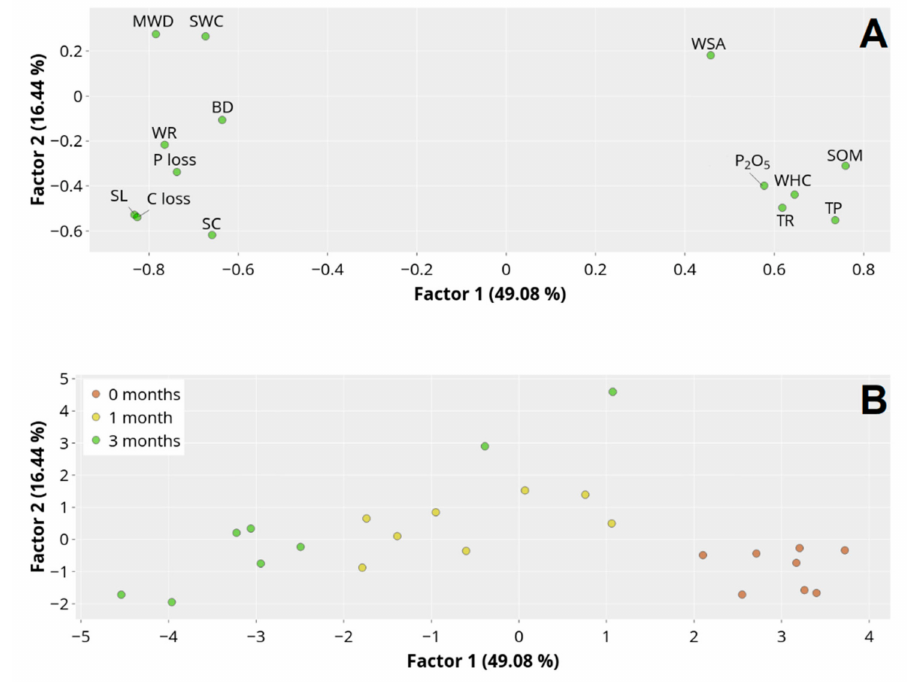
Figure 7. Results of the principal component analyses. Relation between Factors 1 and 2, ( A ) variables and ( B ) cases. Bulk density (BD); water holding capacity (WHC); soil water content (SWC); mean weight diameter (MWD); water-stable aggregate (WSA) content; soil organic matter (SOM); available phosphorous (P 2 O 5 ); time to ponding (TP); time to runo ff (TR); water runo ff (WR), sediment concentration (SC); sediment loss (SL); carbon loss (C loss) and available phosphorous loss (P